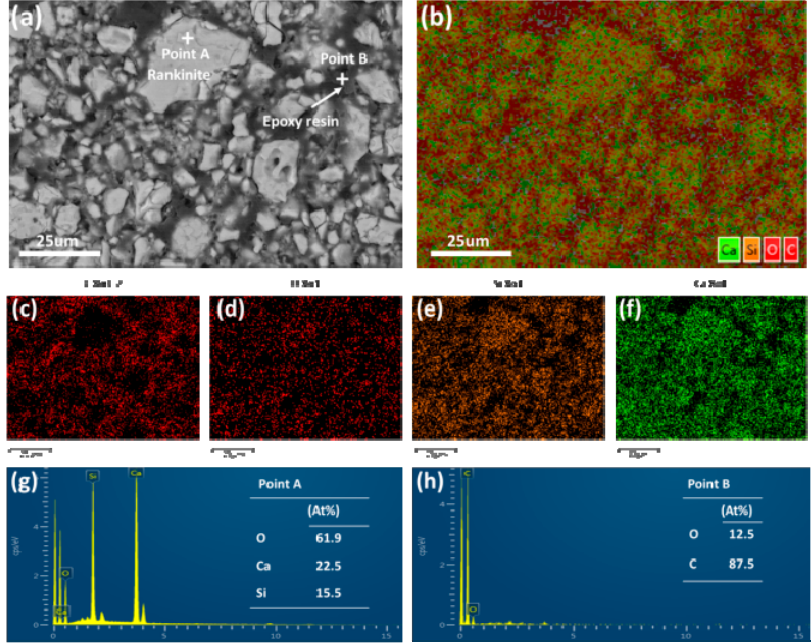
Figure 5. SEM and EDS images of the compacted C 3 S 2 samples before carbonation: ( a ) Backscattered Electron (BSE) image, ( b – f ) elemental maps for composite elements and C, O, Si, Ca, respectively, ( g , h ) EDS analysis of point A and